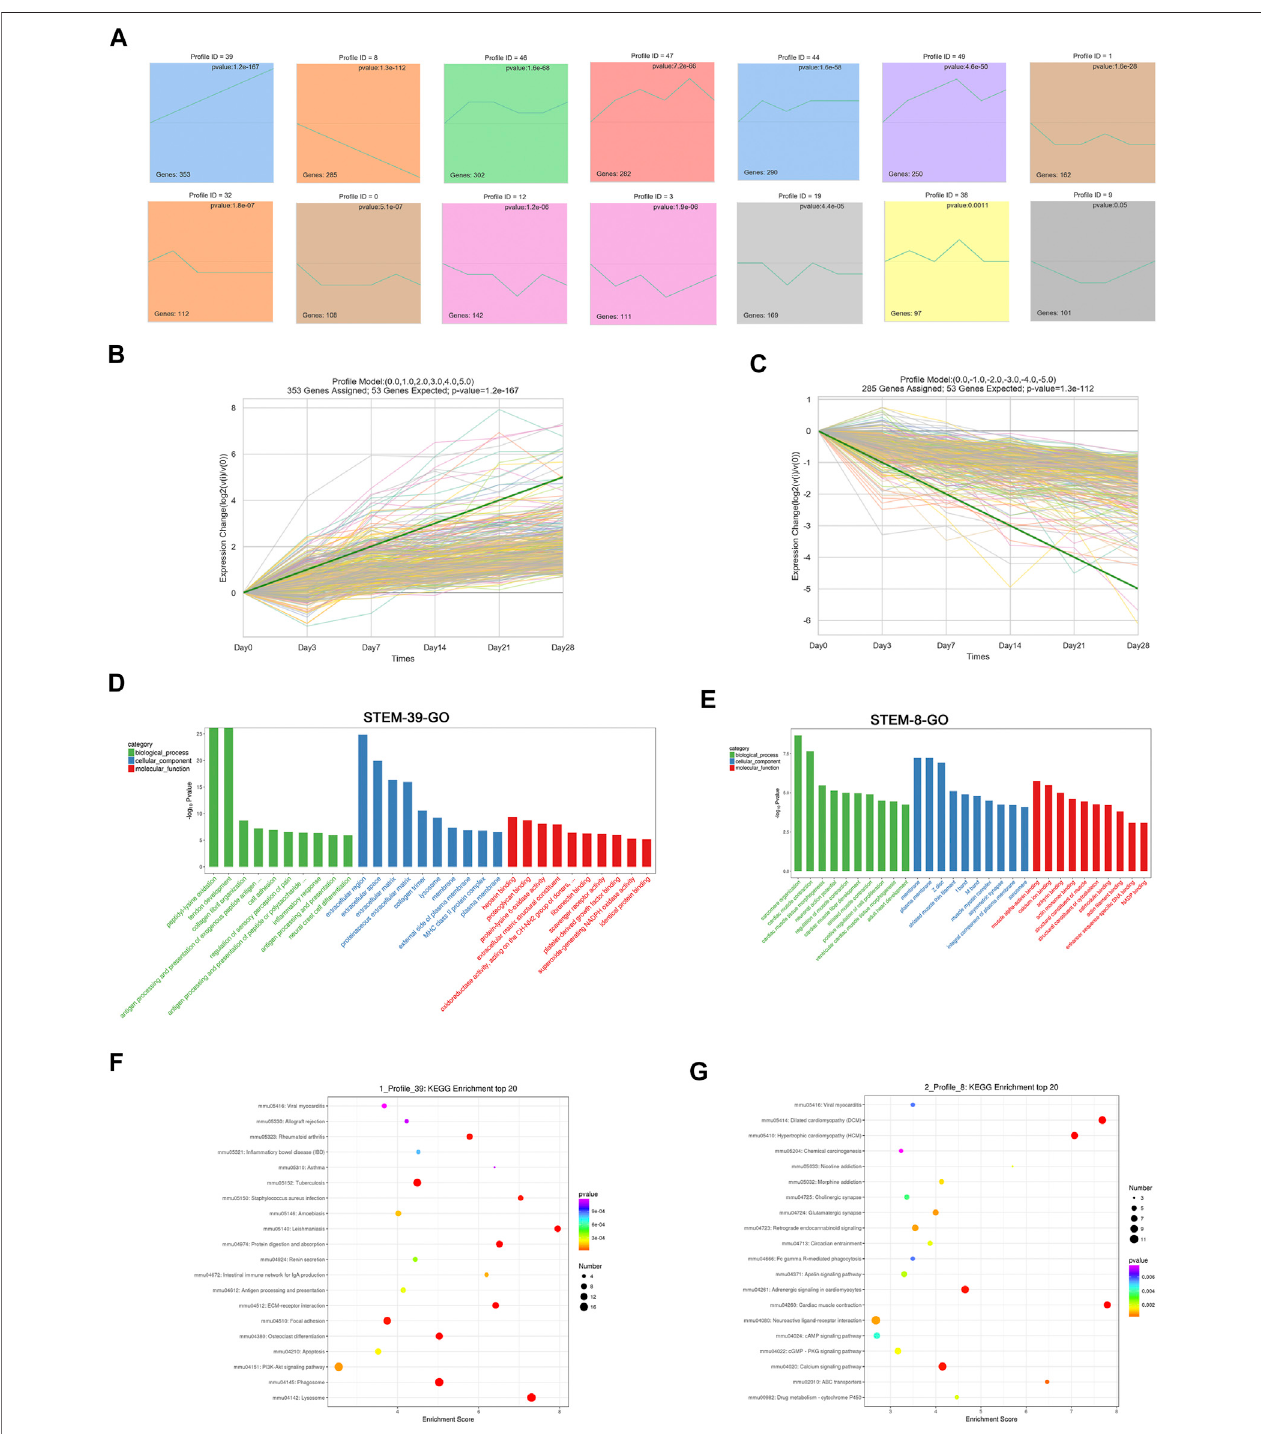
FIGURE4| Shorttime series expression miner(STEM) analysisofDEGsatdifferentstages. (A) STEManalysisidenti fi ed14signi fi cantlyexpressed pro fi leswitha p value of < 0.05. The numbers of genes in each pro fi le are shown in the bottom left corner, and the p value of each corner is shown in the top right corner. (B) Expression patterns of Pro fi le 39. (C) Expression patterns of Pro fi le 8. (D) GO analysis of Pro fi le 39. (E) GO analysis of Pro fi le 8. (D – E) GO analysis of pro fi les using the biological process, cellular component, and molecular function categories. Green indicates the biological process, blue indicates the cellular component, and red indicates the molecular function. (F) Top 20 KEGG pathways of Pro fi le 39. (G) Top 20 KEGG pathways of Pro fi le 8. (F – G) X-axis indicates the enrichment scores. The size of the bubble indicates the number of genes enriched in the indicated pathway.